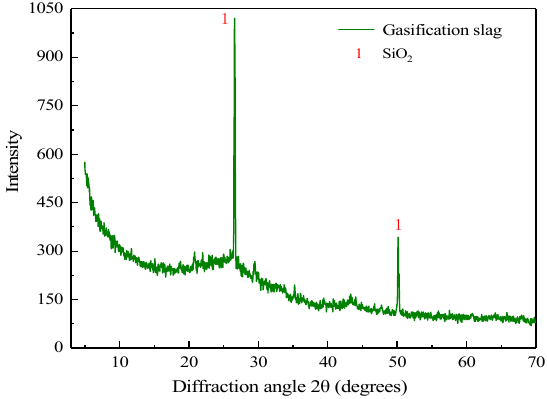
Figure 4. Qualitative XRD diffraction analysis profile of gasification slag.